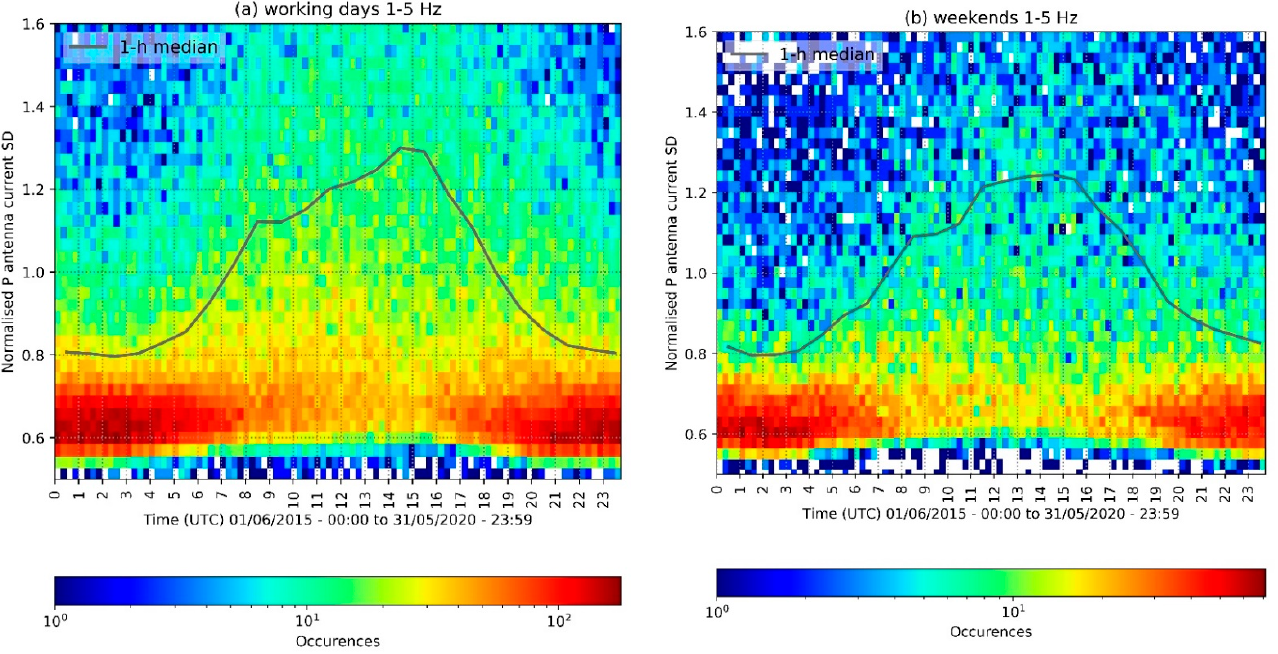
Figure 5. Diurnal variation of the standard deviation of current induced on the antenna in the 1–5 Hz frequency range (1 June 2015–31 May 2020) during ( a ) working days (Mon–Fri) and ( b ) weekends only (Sat-Sun).